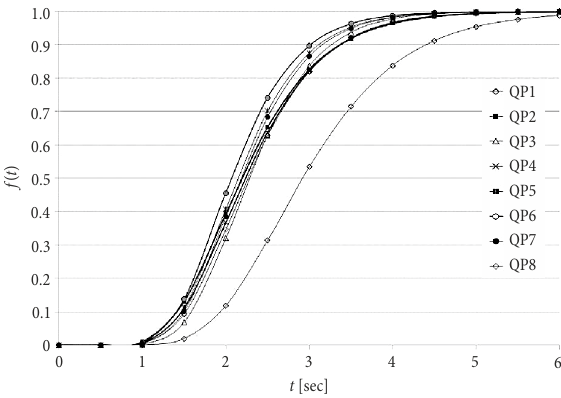
Fig. 3. Cumulative distribution plots of headways for median lane